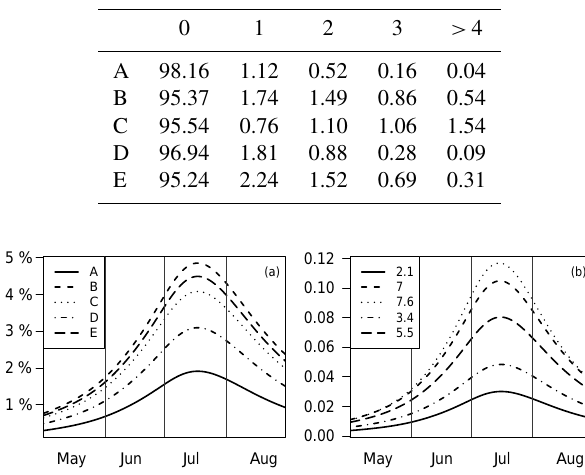
Table 2. Relative frequencies (%) of number of flashes (columns) for 20 July of the sample locations (rows) in Fig. 1 derived from the occurrence and intensity GAM.